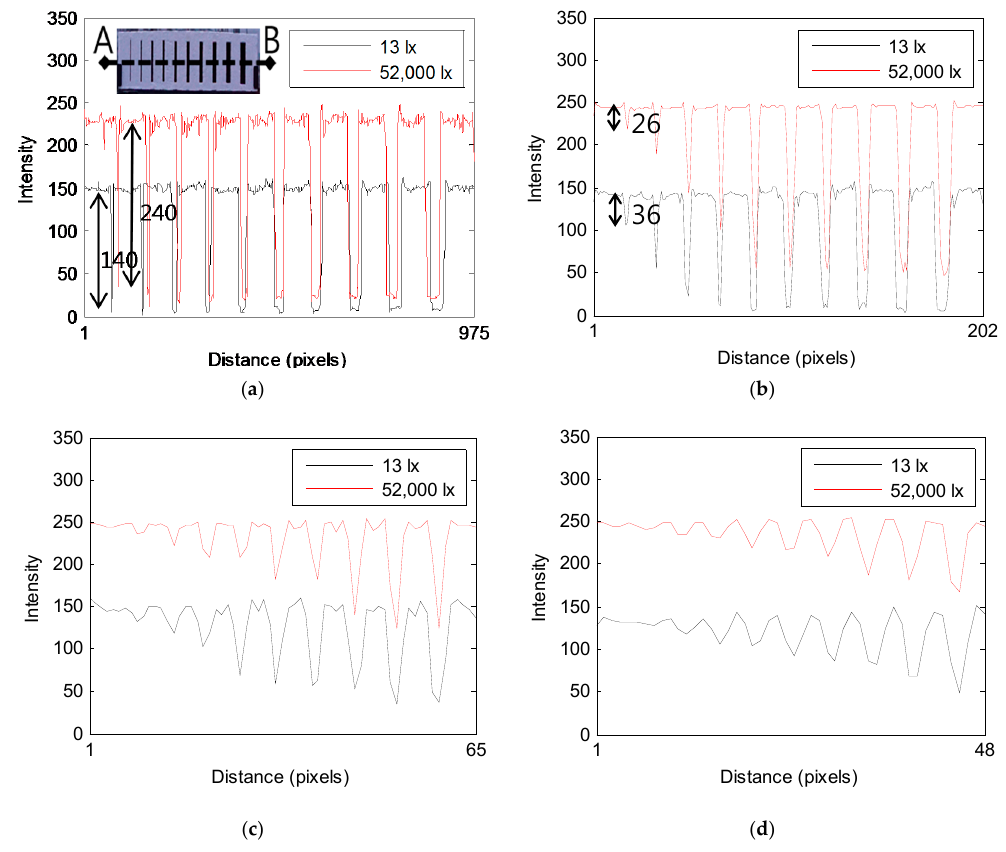
Figure 8. Comparison of the intensity profile between specimen images acquired with the illuminations of 13 lx and 52,000 lx at object distances of: ( a ) 5 m, ( b ) 25 m, ( c ) 75 m, ( d ) 100 m.